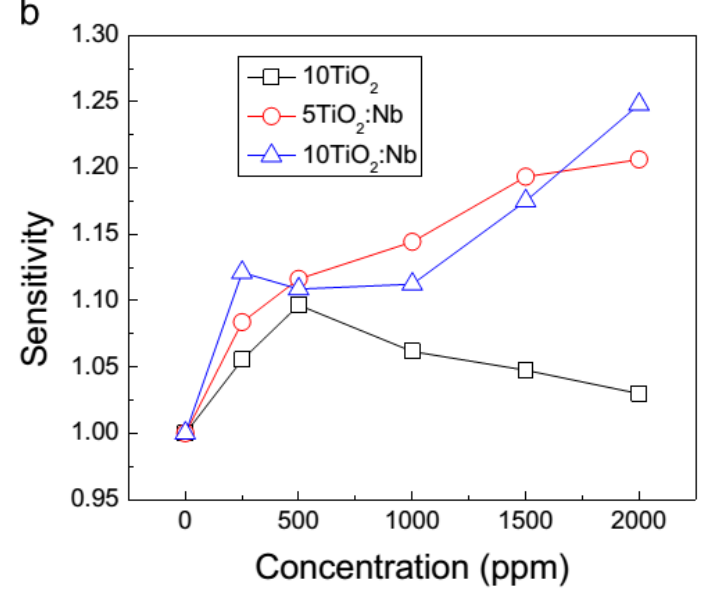
Figure 20. Sensitivity to CO of different tested sensors (with doped or undoped TiO 2 -based sensitive films) at T w = 400 °C, from ref. [89].